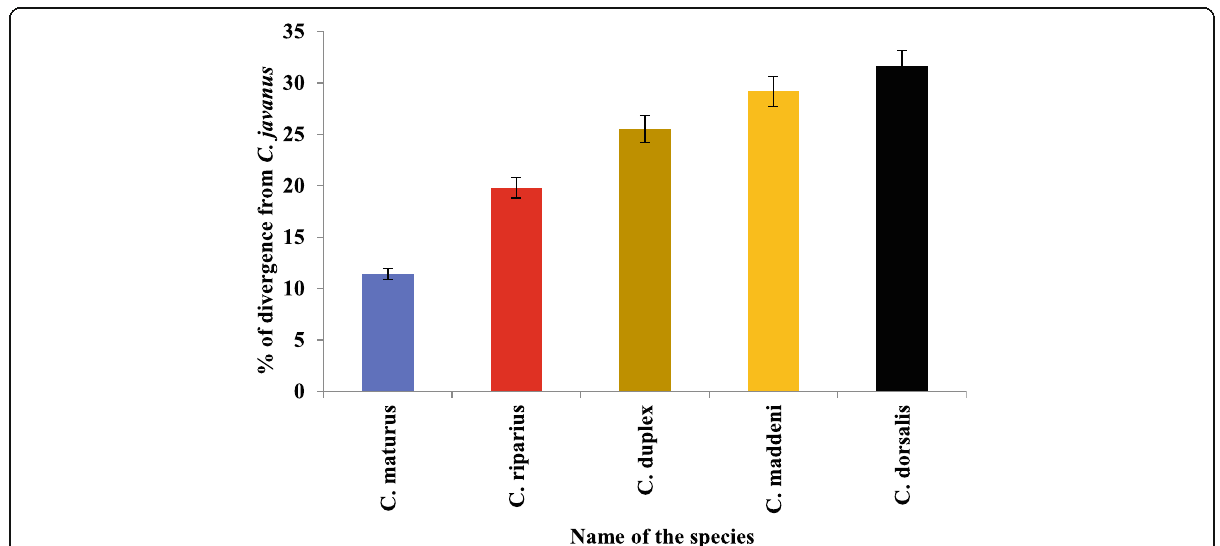
Fig. 9 Graphical representation of the degree of divergence (%) of five species of Chironomus from C. javanus , based on their polytene chromosome